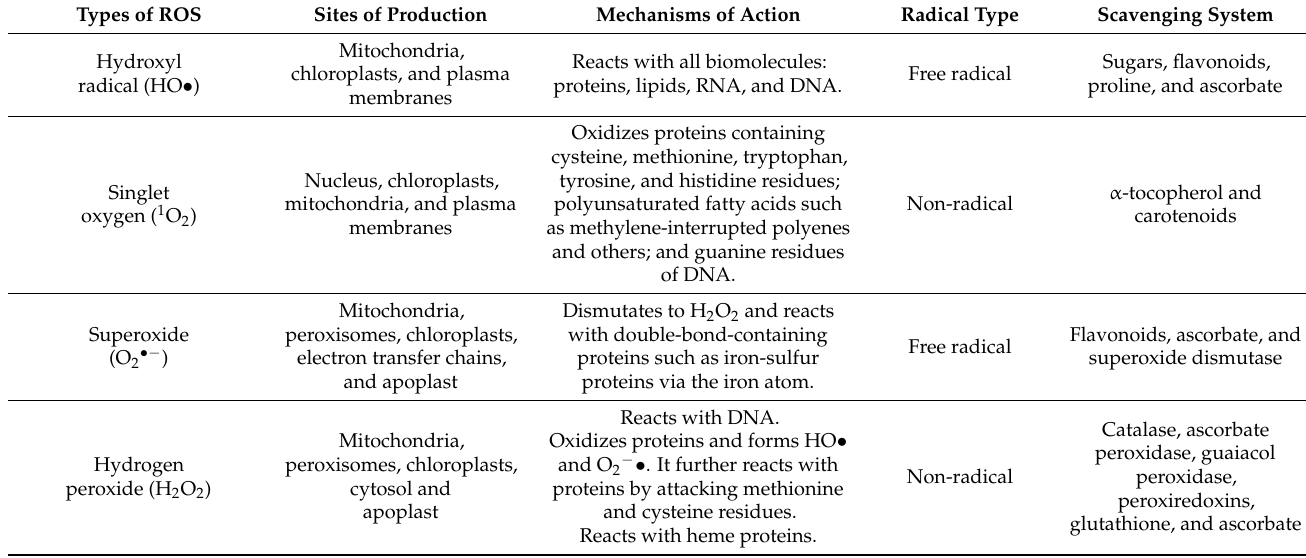
Table 1. Different types of ROS ( 1 O 2 , HO • , O 2 − • , and H 2 O 2 ), their place of production, mechanisms of action, and scavenging